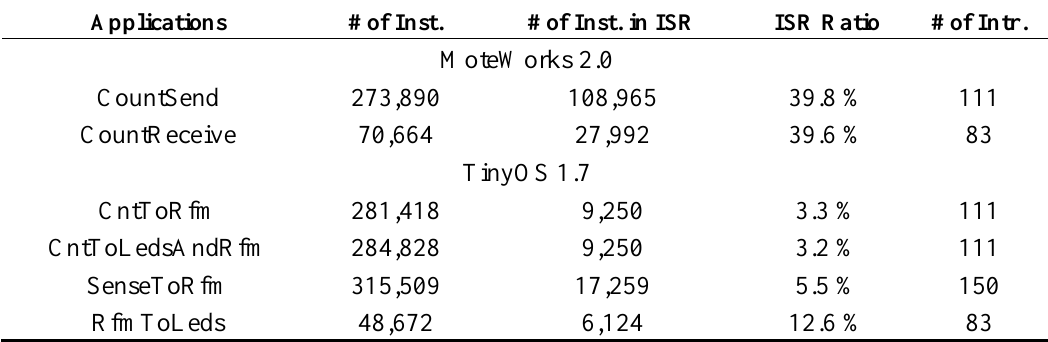
Table 2. Profiling results of sensor network applications for ISRs. Applications # of